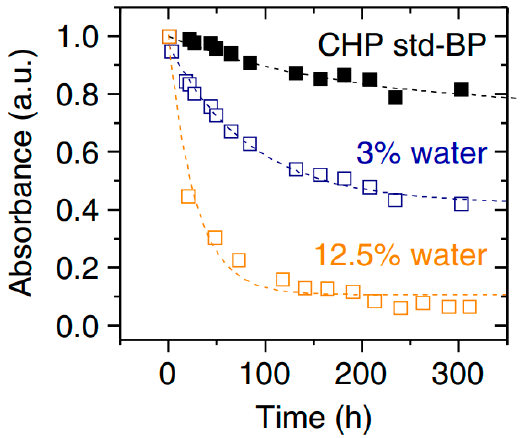
Figure 23. The stability of absorbance (465 nm) by black phosphorous nanosheets exfoliated in different conditions: 1-Fitted time-dependent data for BP nanosheets exfoliated in CHP and 2, 3 data for BP exfoliated in CHP solution with 3 vol% and 12.5 vol% of water added. Reproduced from Ref. [59]. Published by Macmillan Publishers Limited as open access, 2015.